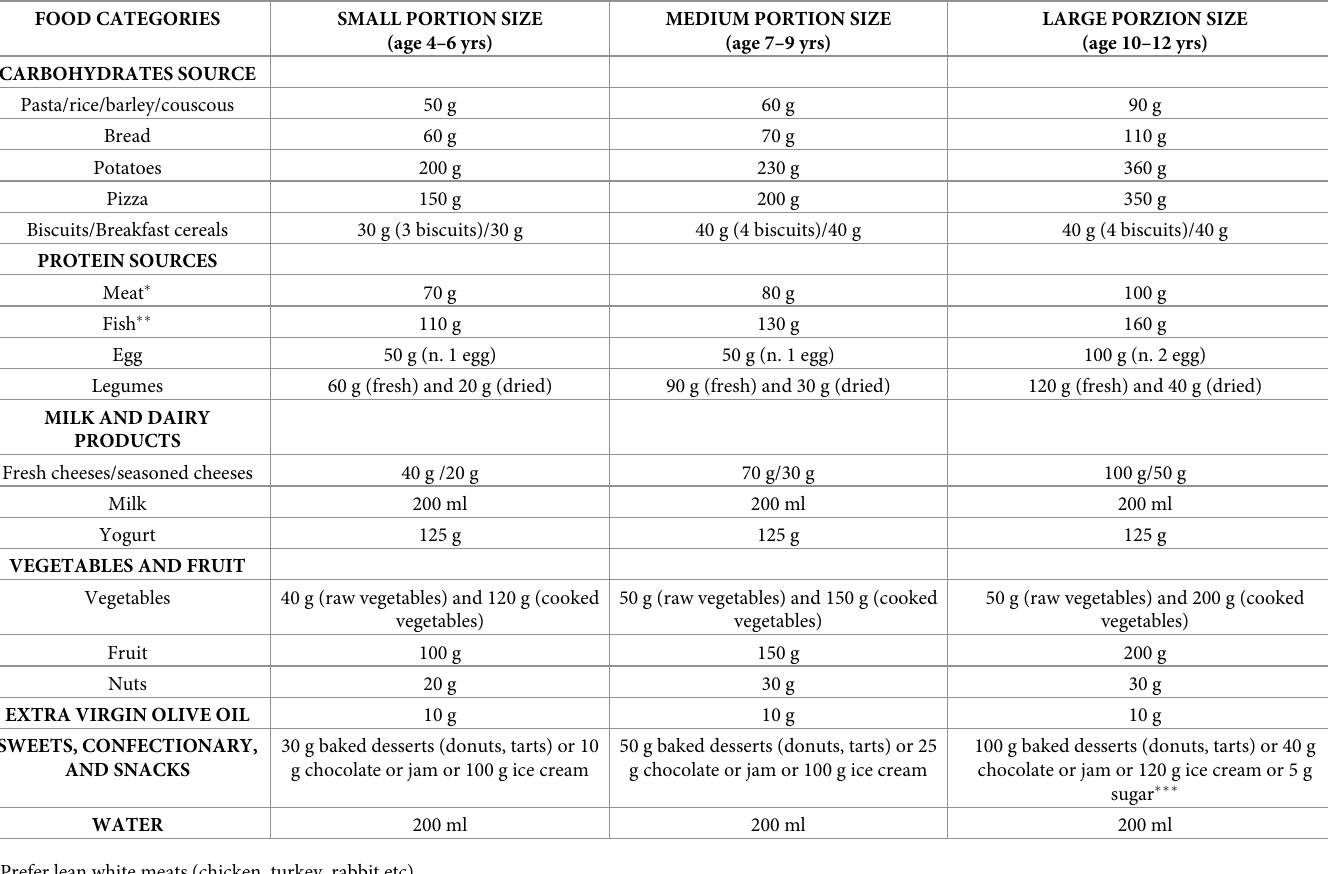
Table 1. Portion sizes. Different portion sizes for each food categories for children aged 4–6 years, 7–9 years and 10–12 years according to